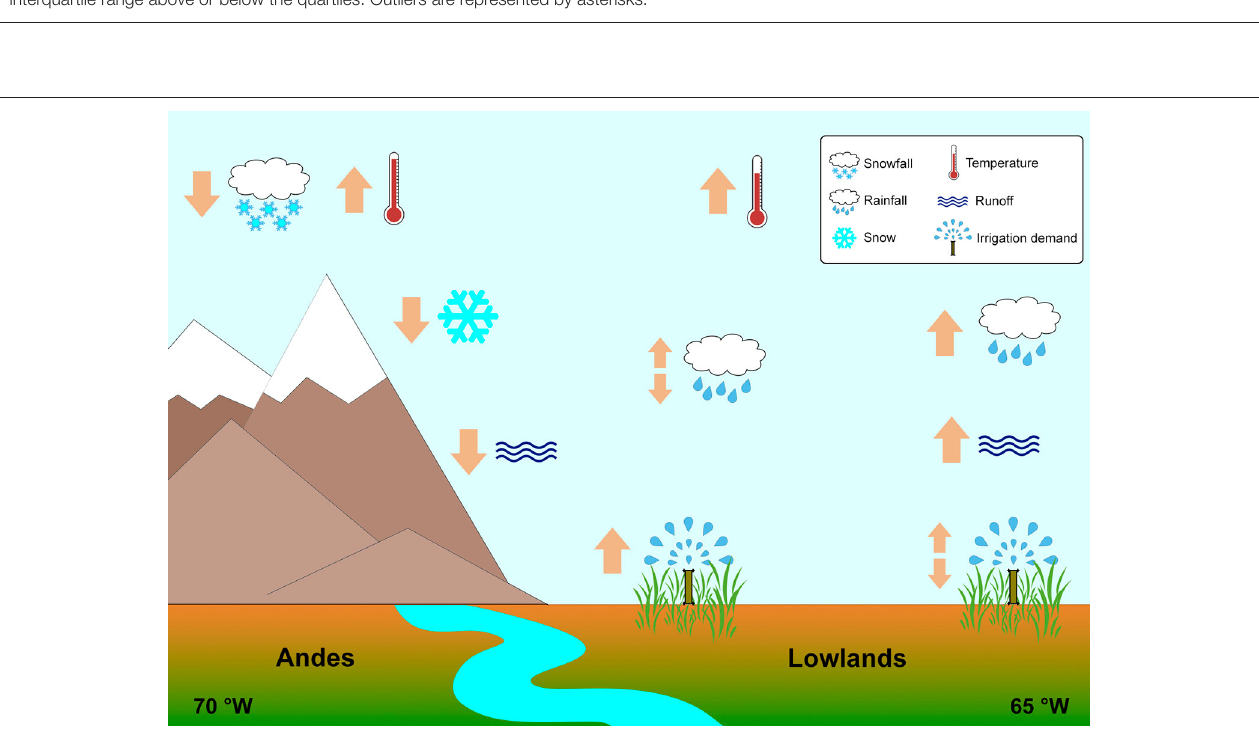
FIGURE 9 | Boxplot of the projected southward expansion of the Hadley Circulation based on the SLP and UAS metrics, expressed as the change in the latitude of the Hadley Circulation edge over the periods where the temperature anomaly is projected to reach 1.5 and 2 ◦ C above preindustrial levels along the Andes region compared to the 1981–2010 baseline. Each boxplot shows the median and first and third quartiles, while the whiskers extend to the data values that are 1.5 times the interquartile range above or below the quartiles. Outliers are represented by asterisks.